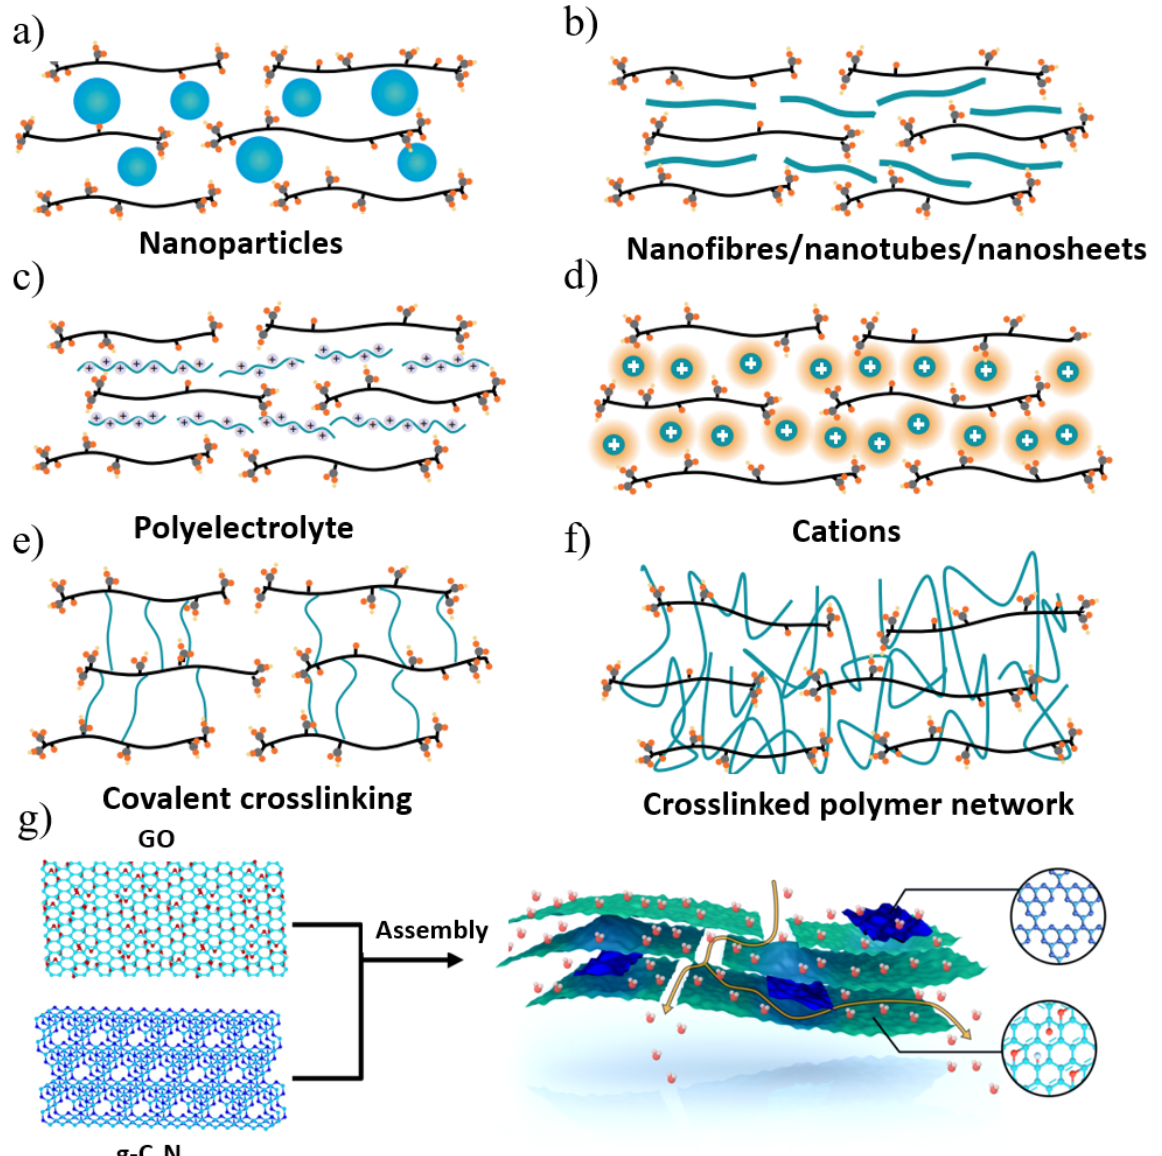
Figure 5. Main strategies for the stabilization of GO membranes and the control of interlayer spacings and their mass transport. ( a ) Nanoparticles; ( b ) nanofibres/nanotubes/nanosheets; ( c ) polyelectrolyte; ( d ) cations; ( e ) covalent crosslinking; ( f ) crosslinked polymer network. ( g ) Illustration of the assembly of GO and g-C 3 N 4 sheets and the transfer mass process. Reprinted with permission from [86,87]. Copyright (2021) Springer Nature Limited part of Springer Nature. Copyright (2021) American Chemical Society.